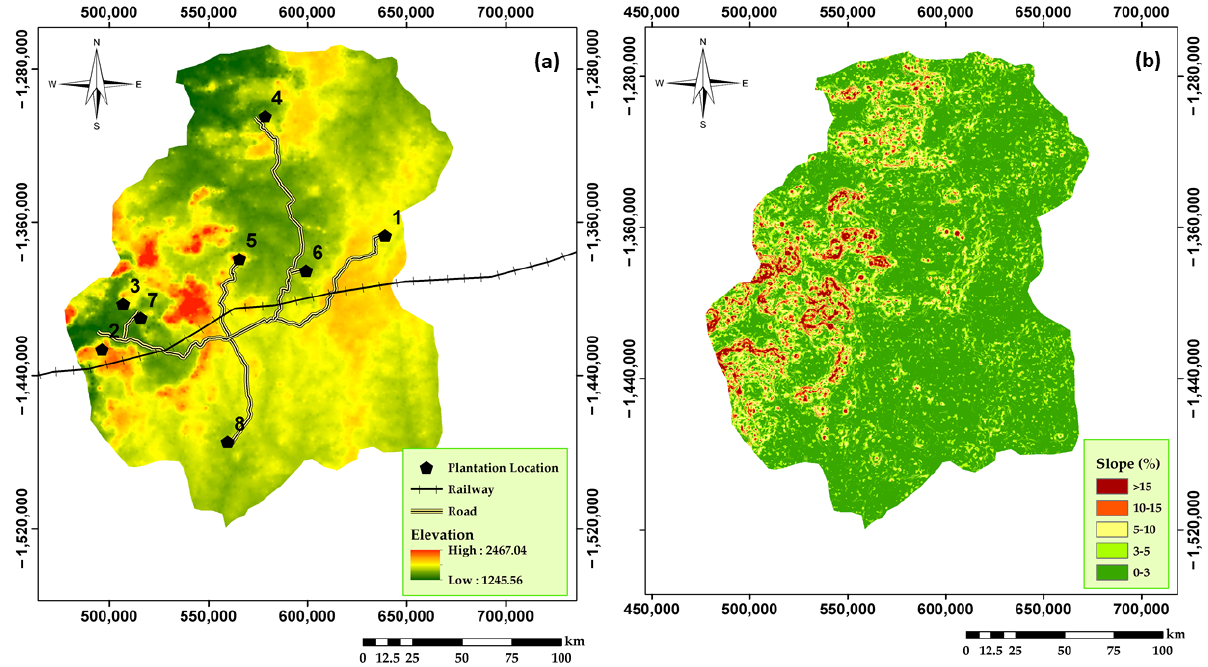
Figure 4. ( a ) Elevation map showing the elevation values across the study area and ( b ) slope percentages classified into 5 classes.